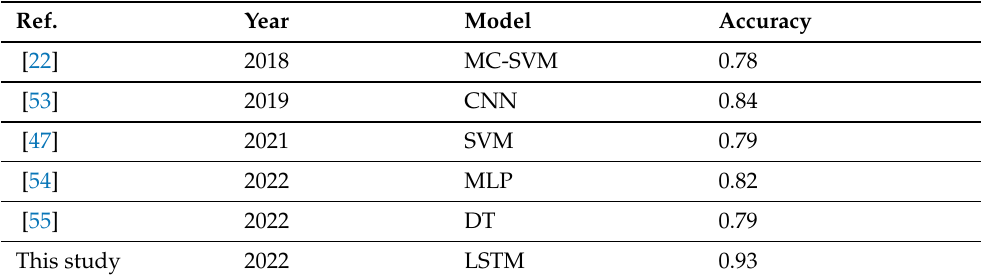
Table 7. Comparison results with other studies.